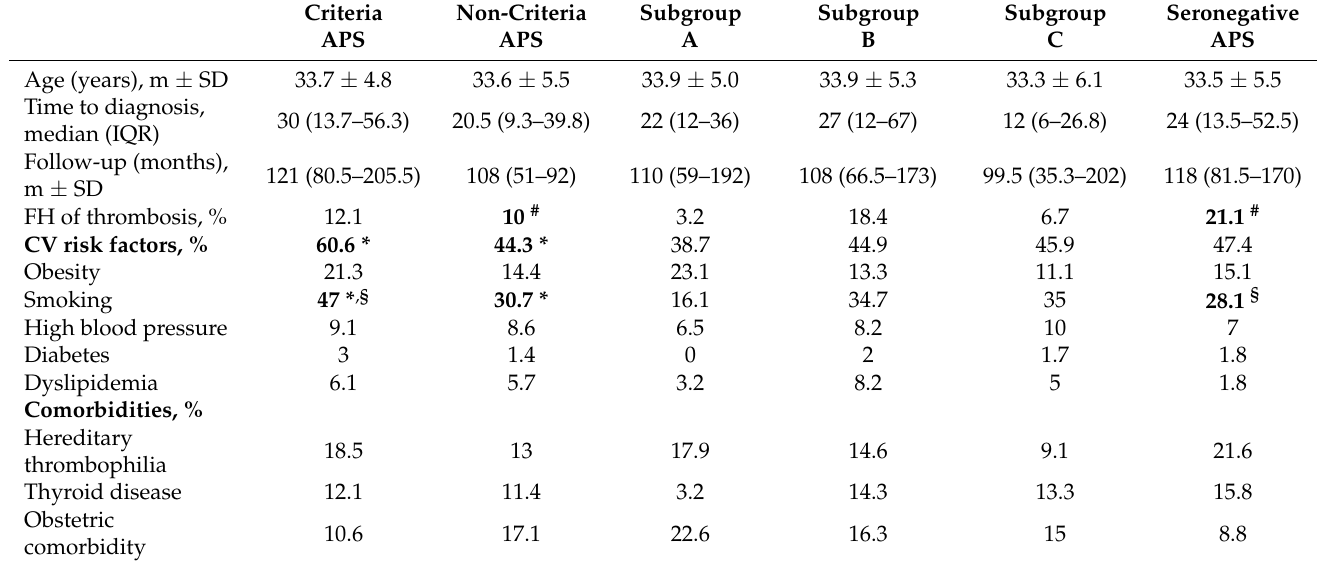
Table 3. Demographic characteristics, cardiovascular risk factors, and main comorbidities in the different study groups.